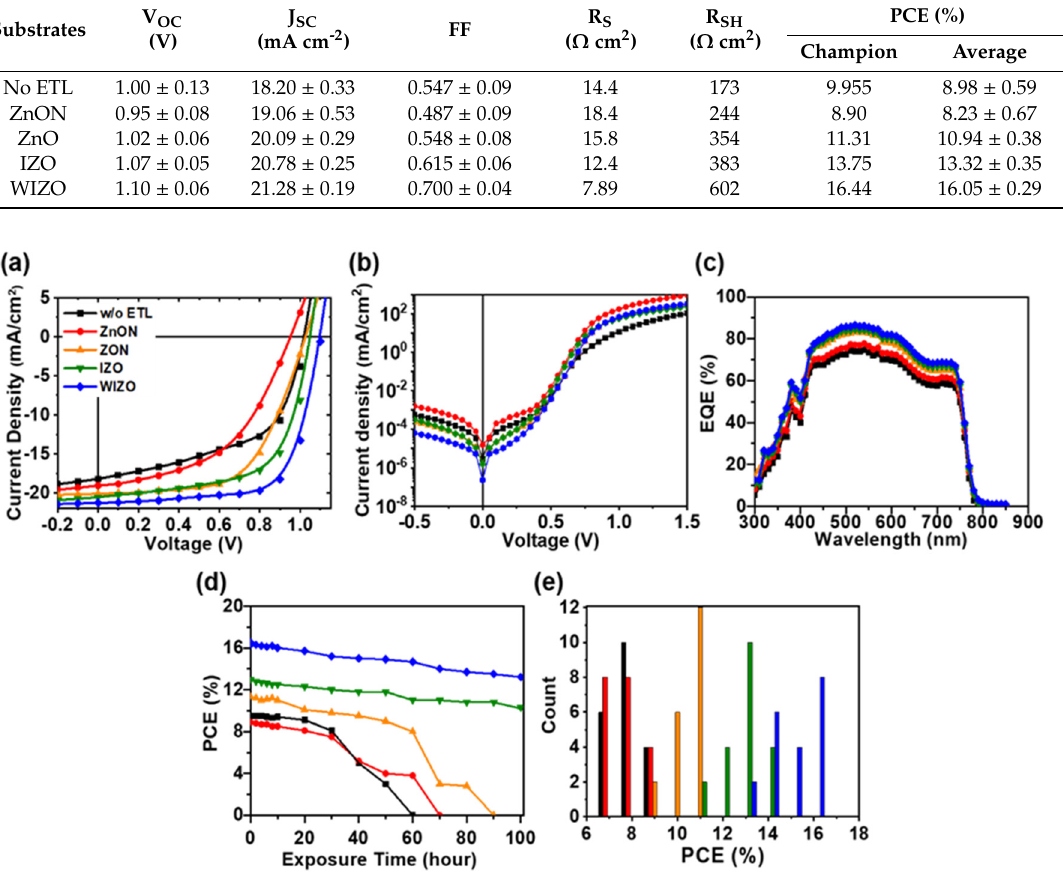
Figure 2. Current Density vs Voltage curves measured ( a ) under simulated AM1.5G solar light and ( b ) under dark. ( c ) EQE spectra, ( d ) stability properties after exposure in Air and ( e ) statistics of the performance for all devices corresponding to ( a ).